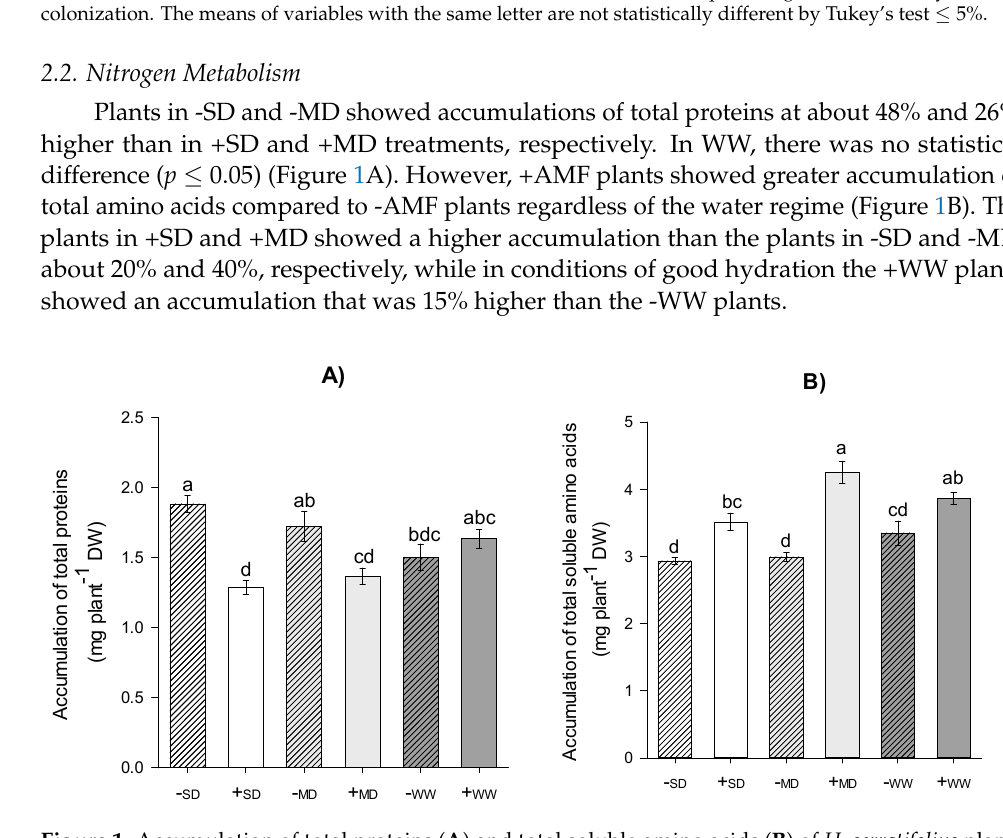
Figure 1. Accumulation of total proteins ( A ) and total soluble amino acids ( B ) of H. serratifolius plants subjected to different water regimes in the presence and absence of arbuscular mycorrhizal fungi. -SD: severe water deficit without AMF; +SD: severe water deficit with AMF; -MD: moderate water deficit without AMF; +MD: moderate water deficit with AMF; -WW: well-watered without AMF; +WW: well-watered with AMF. The means of variables with the same letter are not statistically different by Tukey’s test ≤ 5%.